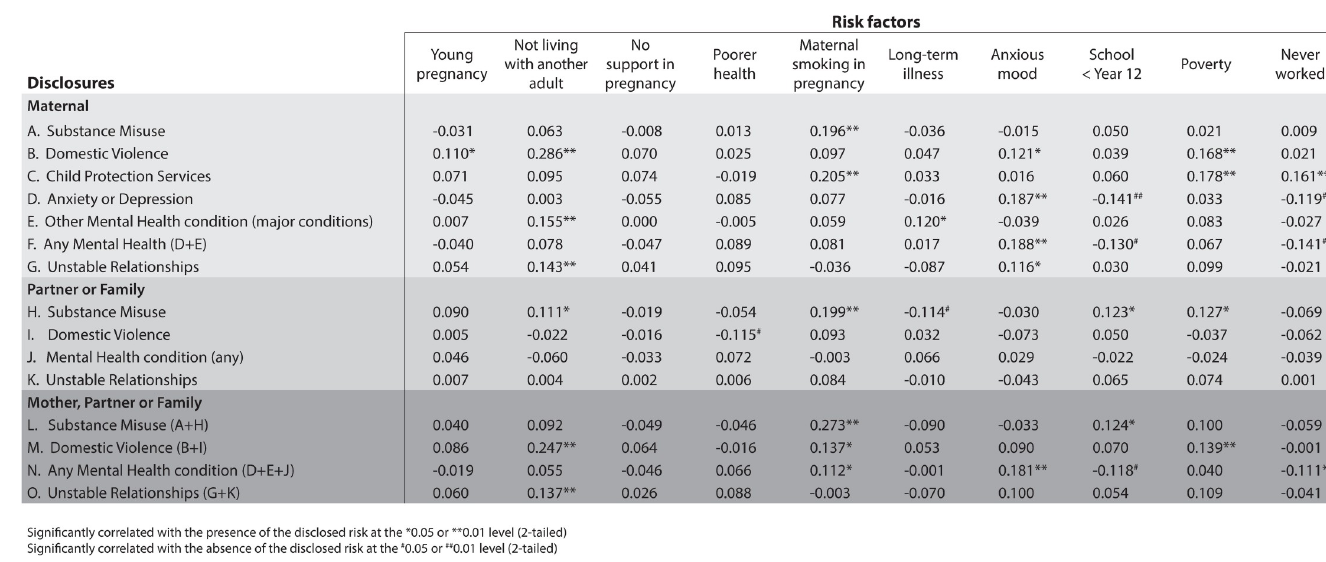
Fig 1. Phi correlations of screening criteria by ACE risk disclosed to MECSH